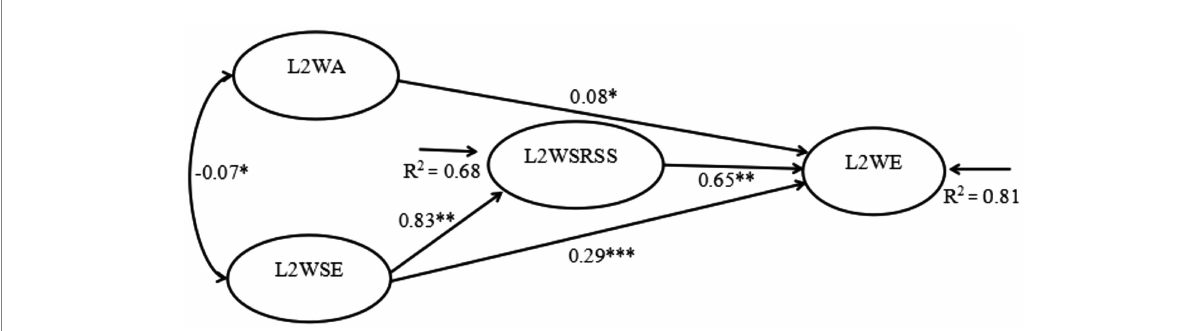
FIGURE 2 Results of SEM model ( N = 340). *** p < 0.001, * p < 0.05; goodness-of-fit indices: χ 2 = 362.84, df = 146, p < 0 .001, CFI = 0.94, TLI = 0.93, RMSEA =0.066; non-statistically significantly paths ( p ≧ 0.05) are not